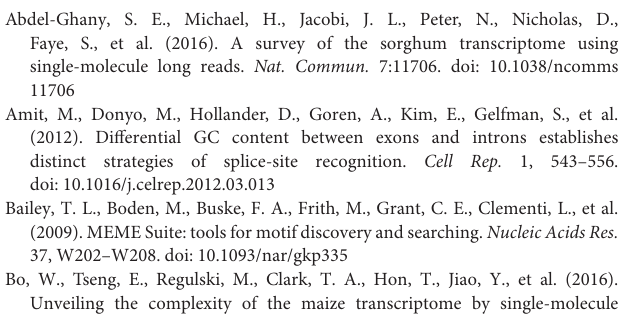
Figure S1 | CIRCOS visualization of different data at the genome-wide level. (A) Karyotype of the chicken genome. (B) The abundance of FLNC transcripts in physical bins of 1Mb for each chromosome. (C) The abundance of short reads generated by RNA-Seq in physical bins of 1Mb for each chromosome. (D) The density of isoforms generated by Iso-Seq. Isoform density was calculated in a 1Mb sliding window at 20kb intervals. (E) The density of known isoforms generated by Ensembl database. Isoforms density was calculated in a 1Mb sliding window at 20kb intervals. (F) Linkage of fusion transcripts: red, intra-chromosomal; green, inter-chromosomal. Figure S2 | RT-PCR validation of AS events during chicken embryo development. Figure S3 | RT–PCR validation of novel genes. Table S1 | Primers sequences used for RT-PCR (DOCX 18kb).